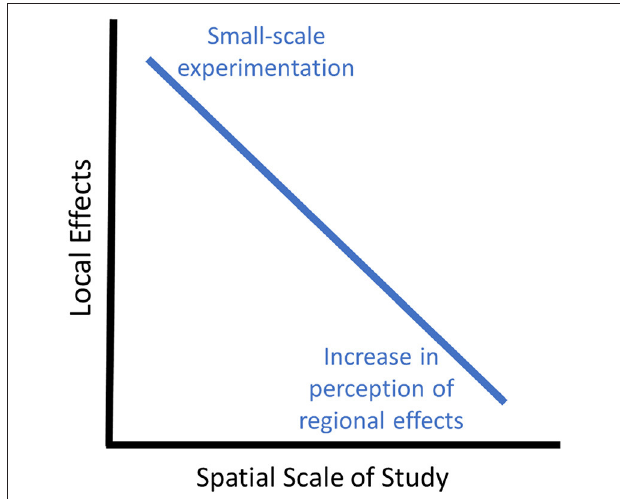
FIGURE 4 | Hypothesized explanation for scale discrepancies in native-invasive relationships. Studies at small spatial scales are only able to perceive local effects and often encourage exacerbated local effects through study design or experimental control. Given the hypothesized relationship between local sorting strength and invasibility ( Figure 5 ), signs of Biotic Resistance are frequently detected. Studies at larger spatial scales or spanning multiple spatial scales are better able to perceive regional-scale effects on community assembly and are more likely to observe positive relationships between native biodiversity and invader biodiversity, especially in heterogeneous